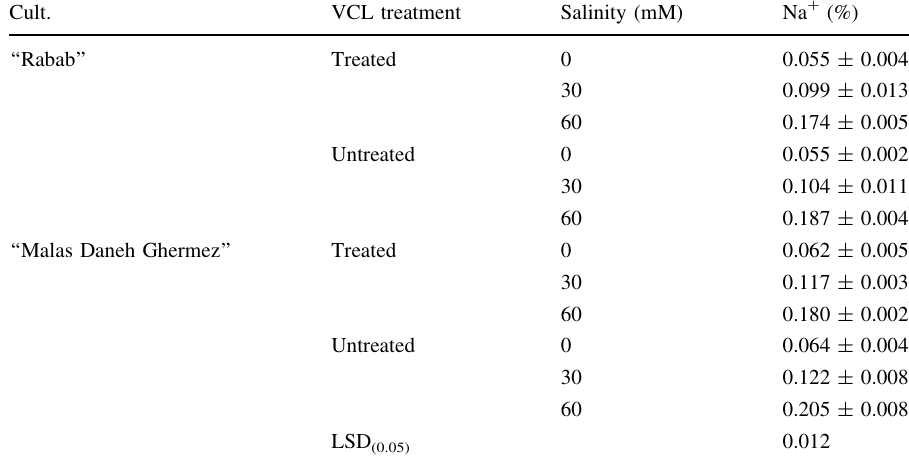
Table 5 Effects of VCL treatments on Na ? content of pomegranate leaf samples under NaCl-induced salt